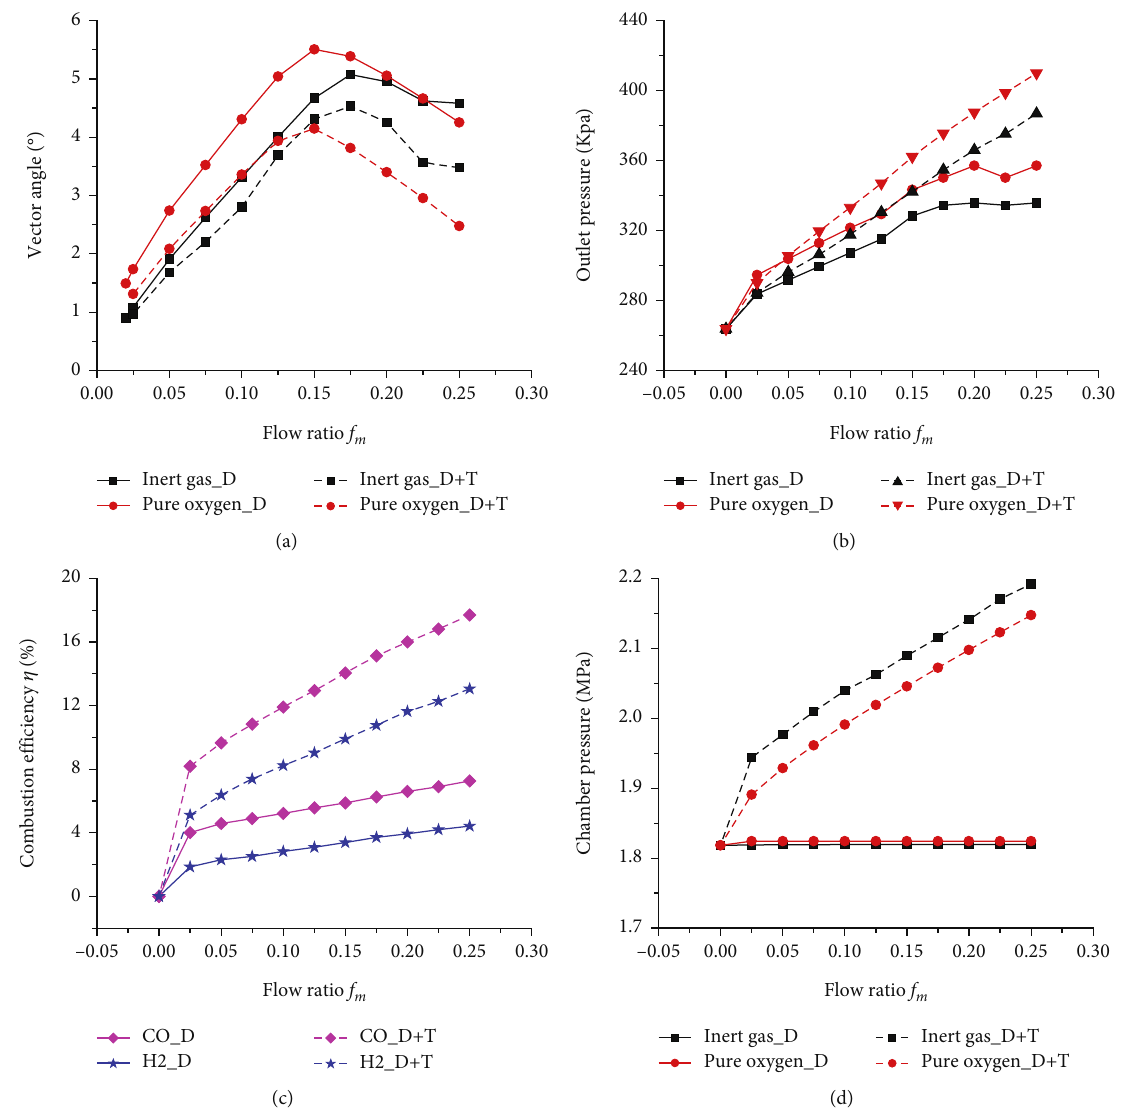
Figure 14: Results of nozzle performance: (a) vector angle; (b) outlet pressure; (c) secondary combustion e ffi ciency; (d) combustion chamber